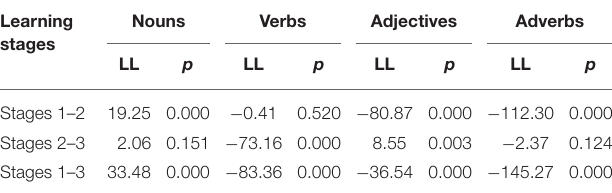
TABLE 7 | Log-likelihood (LL) tests for lexical word classes across learning stages. Learning